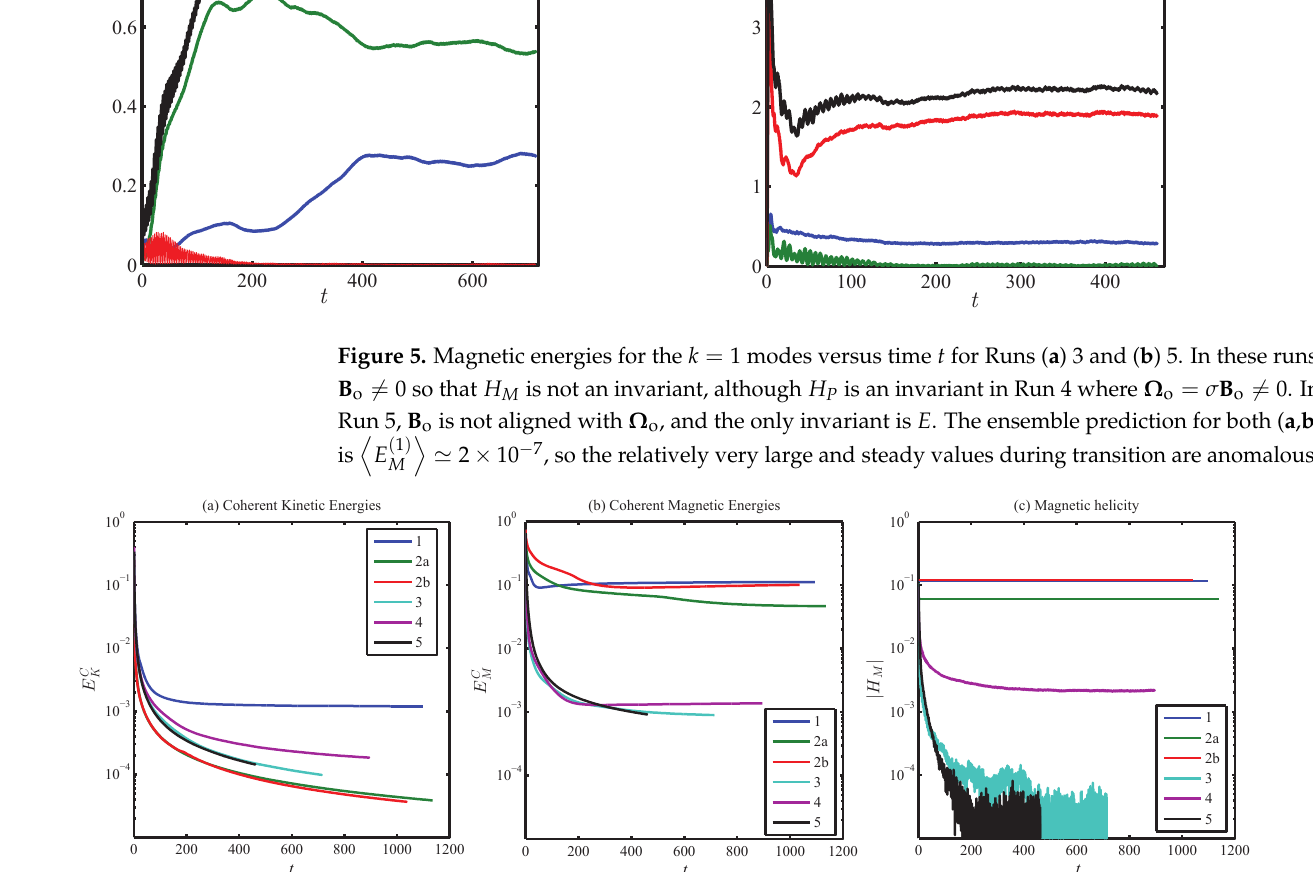
= 0 = 0. In ̸ (cid:54) = 0. In Run 5, B o is not aligned with ̸ (1) 7 , so the relatively very E 2 10 − M ≃ × D E